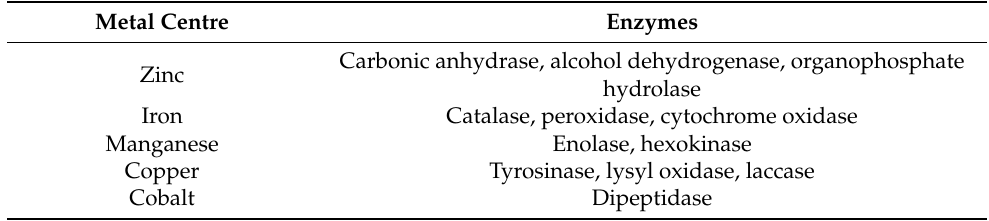
Table 1. Examples of